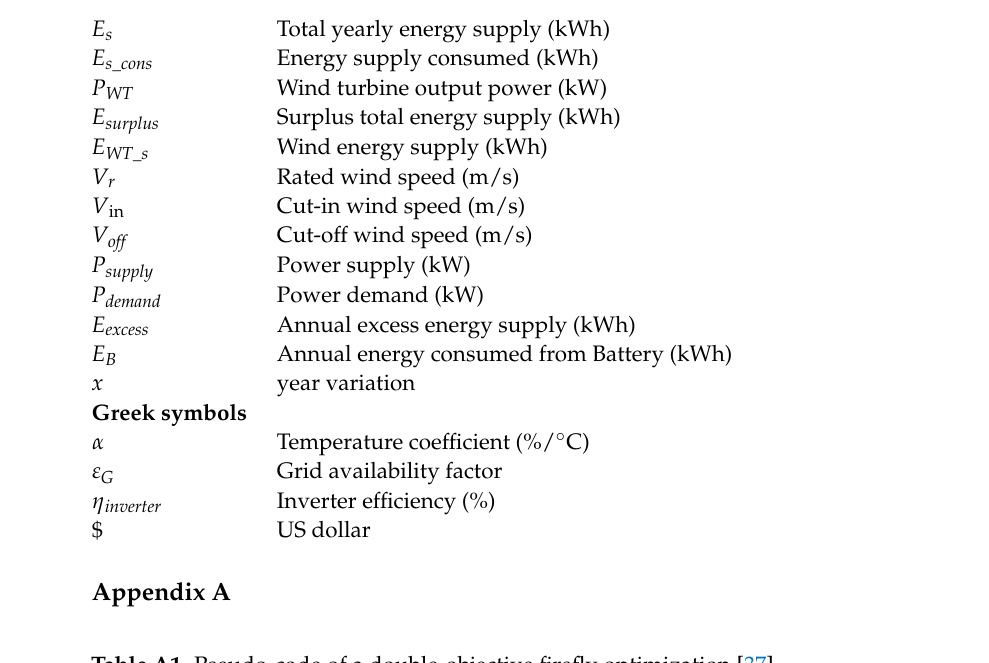
Table A1. Pseudo-code of a double-objective firefly optimization [37]. Define the objective functions y 1 ( χ ), y 2 ( χ ) where the vector χ = ( µ 1 , . . . , µ k ), k is the number of